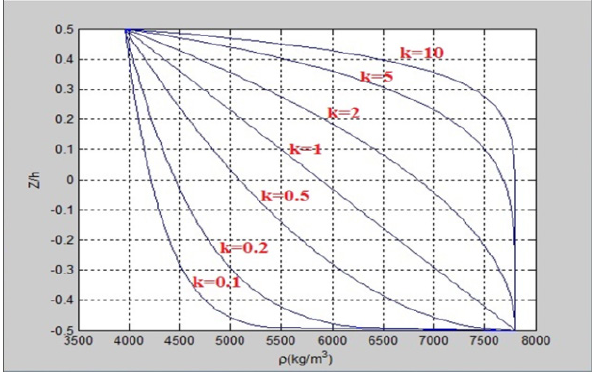
Figure 3: Variation of young modulus through the thickness direc- tion of the beam